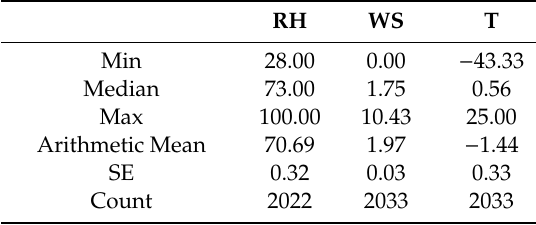
Table2. Statisticalsummaryofdailyaveragemeasurementsofwindspeed(WS,m / s), temperature(T, ◦ C) and relative humidity (RH, %) in Fairbanks from 3 November 2013 to 30 May 2019. (SE: standard error).